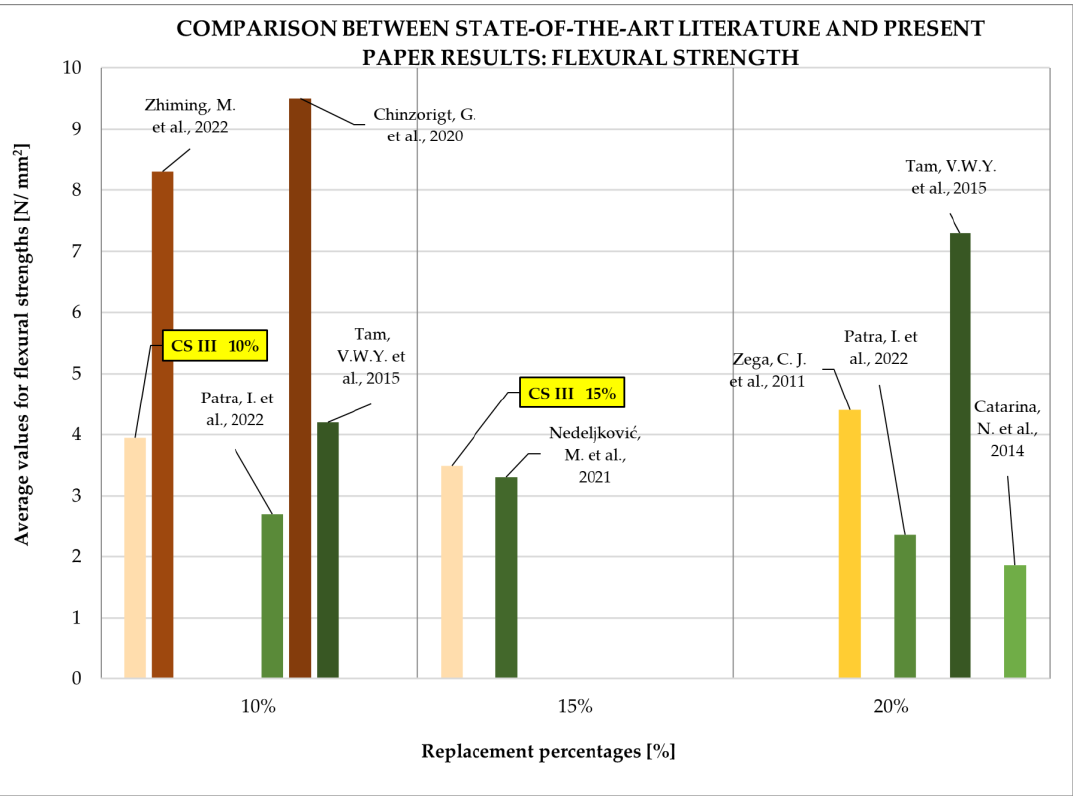
Figure 19. State-of-the-art and present research results for flexural strength [3,4,9 – 11,16,27].